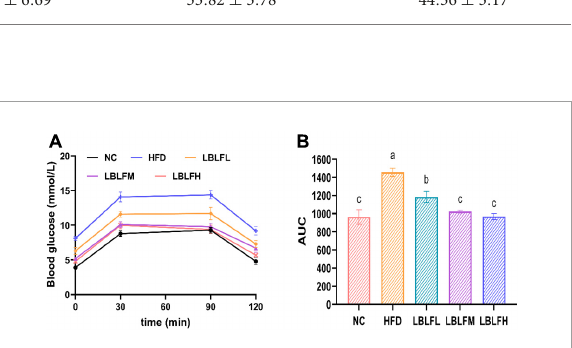
FIGURE2 Effects of LBLF supplement on glucose tolerance in obese mice. (A) Oral glucose tolerance test (OGTT); (B) the integrated areas under each curve (AUC) after oral glucose. Different lowercase letters with significant differences ( p < 0.05).